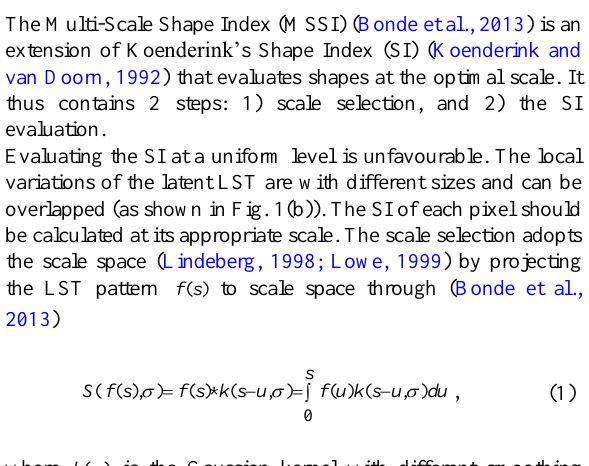
The MODIS/Aqua (MYD11A1) V5 Daily L3 Global 1km Grid point. The MYD11A1 data is acquired at 0130h and 1330h local time. As the SUHI magnitude peaks at afternoon, the data at 1330h is used. The accuracy of the LST data is better than 1K (0.5K in most cases). The LST is converted to